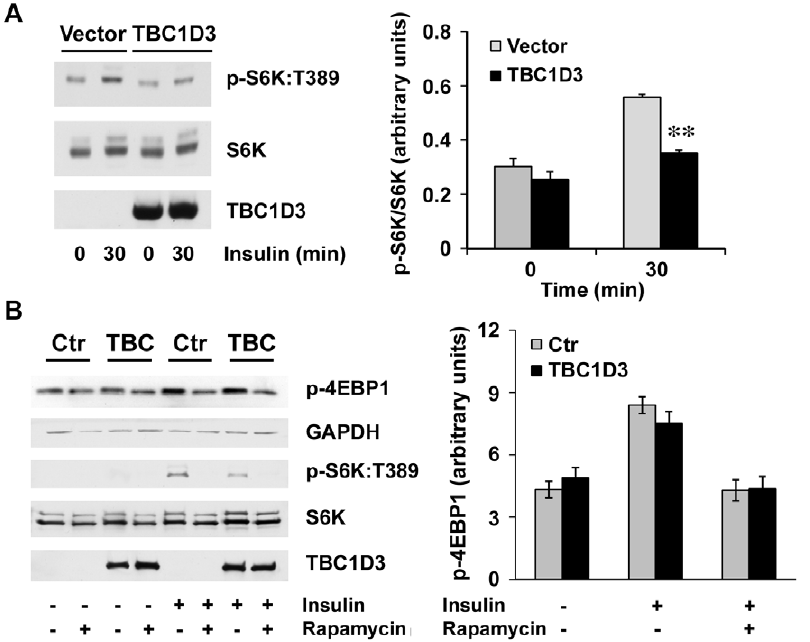
Figure 4. TBC1D3 reduces S6K activation, but does not affect mTOR-C1 pathway. (A) HepG2 cells transfected with myc-TBC1D3 or empty vector were serum-starved, and stimulated with insulin (10 nM) for 30 min. Phosphorylation and protein levels of S6K were analyzed by Western blotting. ( Right panel ) Quantification data of S6K:T389 phosphorylation normalized to S6K protein levels (** p , 0.01). (B) HepG2 cells transfected with myc-TBC1D3 or empty vector were serum-starved, pre-treated with Rapamycin (50 nM) for 2 h, and stimulated with insulin (10 nM) for 30 min. Phosphorylation and protein levels of 4EBP1 and S6K were analyzed by Western blotting. ( Right panel ) Quantification data of 4EBP1 phosphorylation normalized to GAPDH protein levels. The data are presented as means 6 SD of three independent experiments.